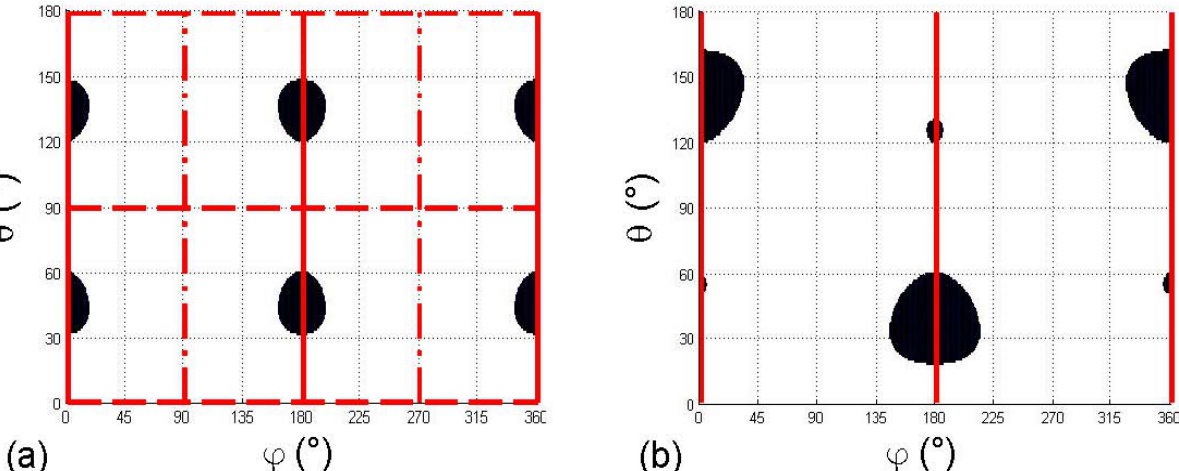
Figure 2. Black zones showing spherical angles coordinates of inversion zones where ' ( , ) ' ( , ) n n θϕ θϕ ≤ from the angular distribution depicted in Figure 1. Figures 2(a) and 2(b): + − Inversion zones related to orthorhombic and monoclinic cases of Figures 1(a) and 1(b), Respectively. Red full lines stand for XZ plane ( ϕ = 0° , 180°, 360° ), red long-dashed lines for XY plane ( θ = 0°, 90°, 180° ), and red dotted-dashed lines for YZ plane ( ϕ = 90°, 270° ) when these dielectric planes are symmetry mirrors for luminescence or absorption